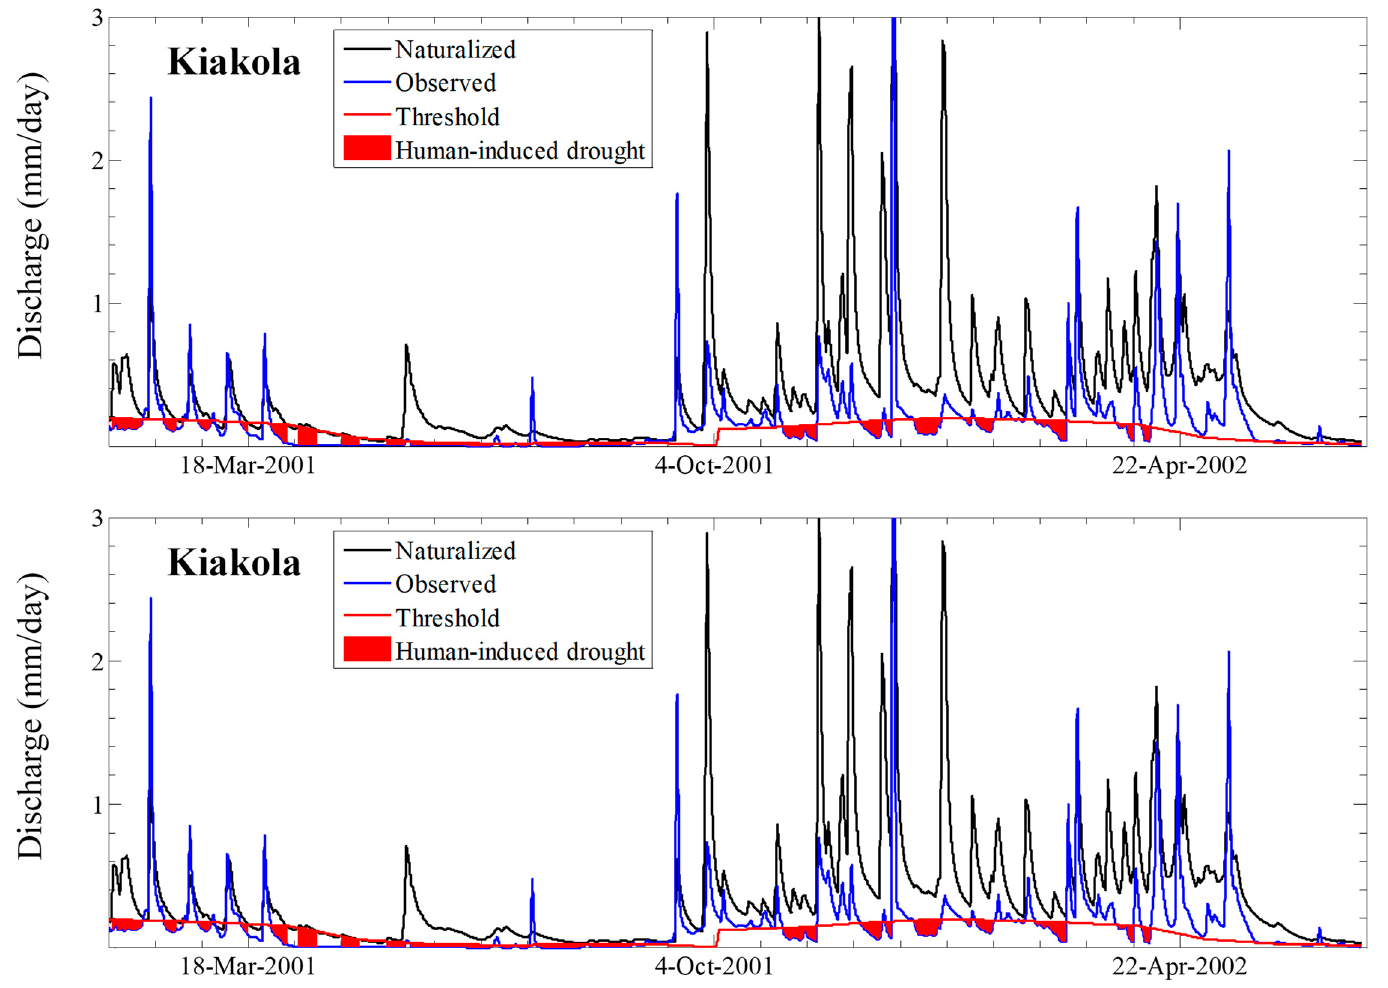
Figure 9. Examples of human-induced droughts .